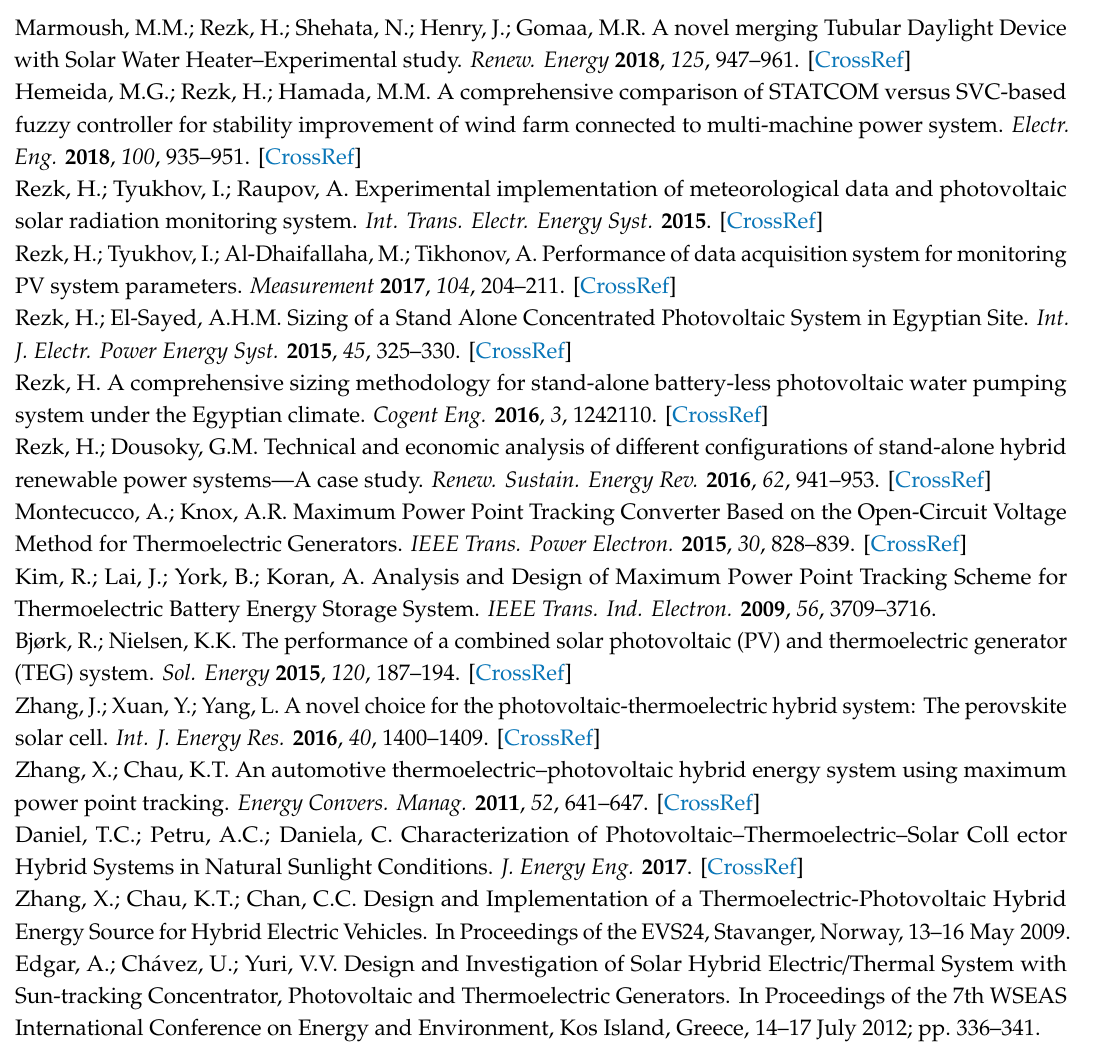
Figure A2. The performance of HPVTEG under different scenarios.